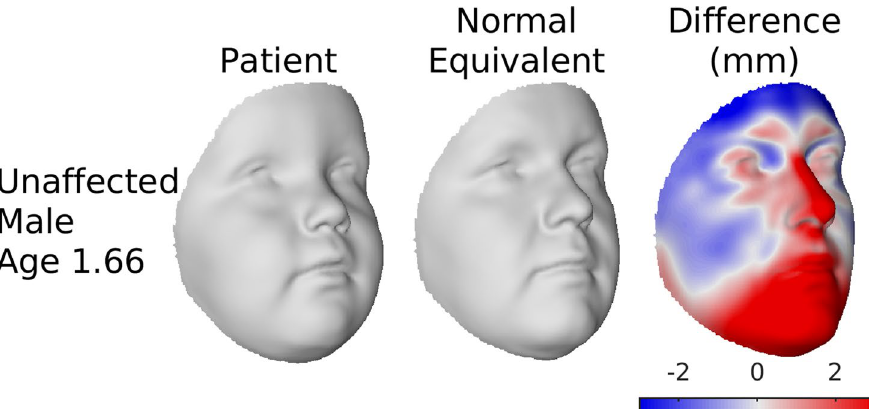
Figure 7. Normal equivalent of unaffected 1.66 year old male average patient morph. The first column shows the patient. The second is their normal equivalent derived using an SSM of 40 year old males. The third shows the difference between the patient and the normal equivalent in mm in the direction perpendicular to the facial surface. The effect is that the typically juvenile features of the morph (a more retrognathic chin and a less prominent nose) are replaced with the more adult features in the normal equivalent. This figure was generated in MATLAB 2021a (https:// www. mathw orks.